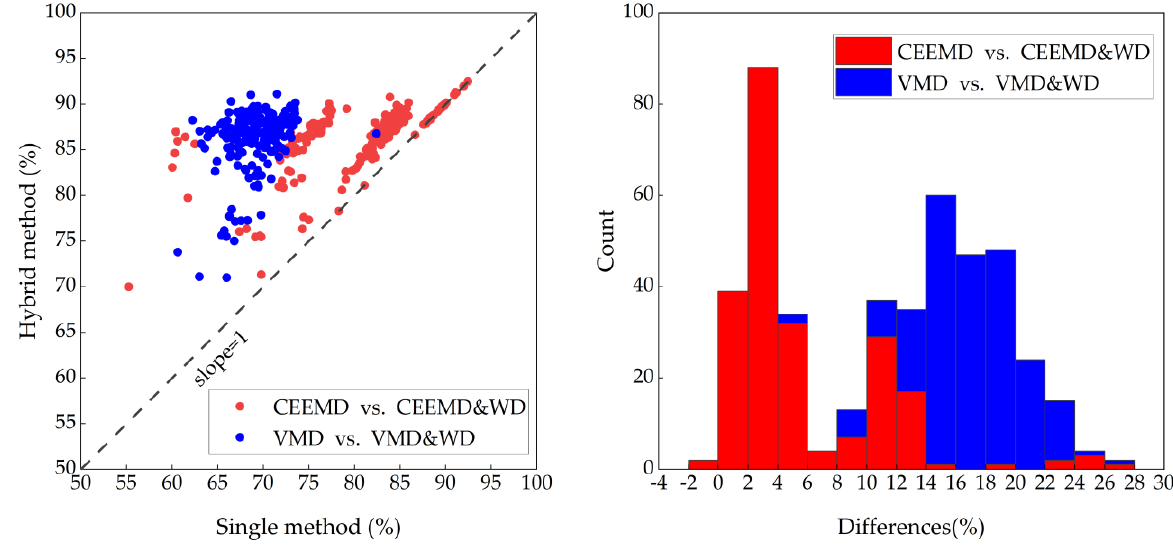
Figure 8. The CRs (left) and their differences (right) of flicker noise for single and hybrid methods.